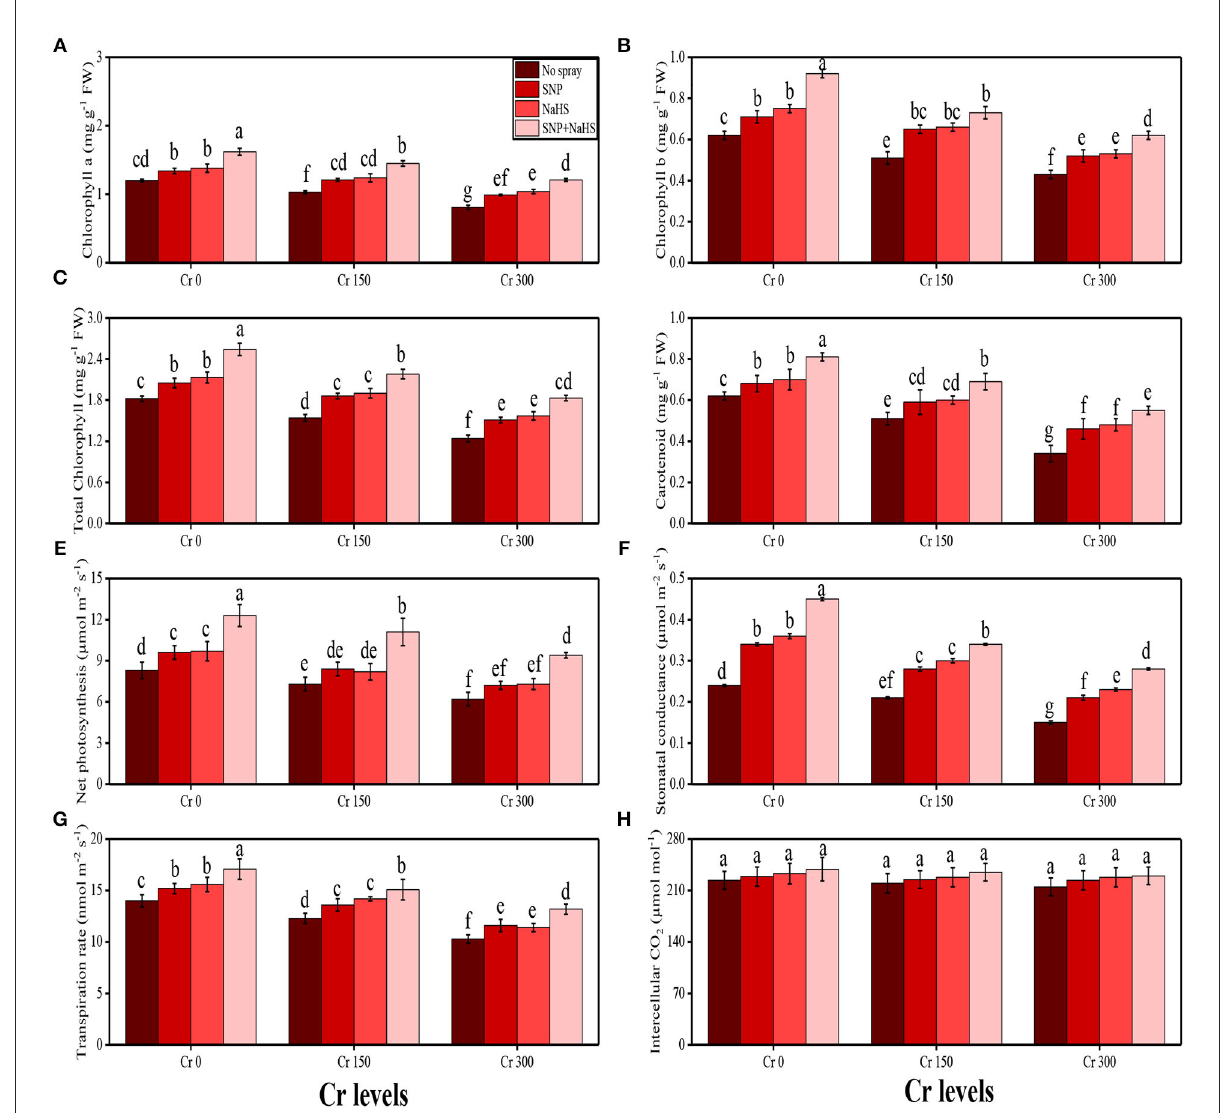
FIGURE2 Impact of individual and combinatorial application of SNP and NaHS on photosynthetic pigments, i.e., chlorophyll-a content (A) , chlorophyll-b content (B) , total chlorophyll content (C) , carotenoid content (D) , net photosynthesis (E) , stomatal conductance (F) , transpiration rate (G) , and intercellular CO 2 (H) of spinach ( S. oleracea ) plants grown under different levels of Cr [0 (no Cr), 150, and 300 µ M] in sandy loam soil. Values in the figures indicate just one harvest. Mean ± SD ( n = 4). Two-way ANOVA was performed and mean differences were tested by HSD ( P < 0.05). Different lowercase letters on the error bars indicate significant differences between the